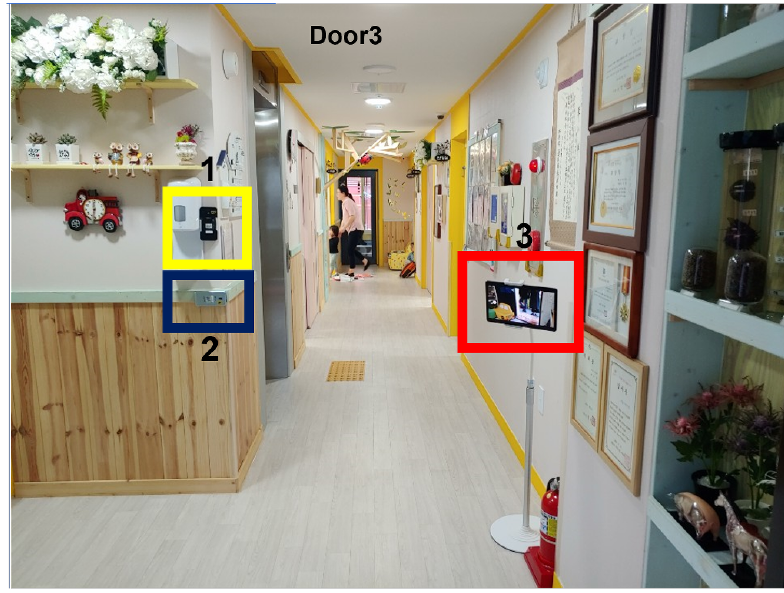
Figure 8. Installation of the camera indoors